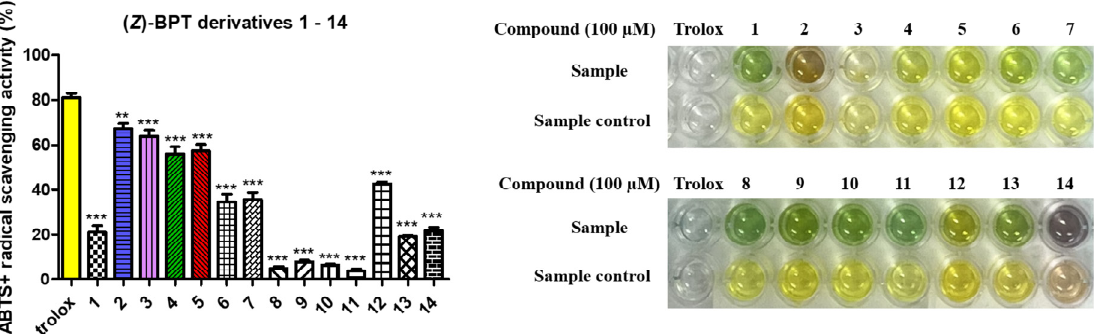
Figure 9. The ABTS cation radical scavenging effects of ( Z )-BPT derivatives 1 – 14 . Test samples 1 – 14 and Trolox, a positive control, were evaluated at a concentration of 100 µM. Asterisks (***) represent a significant difference between the ( Z )-BPT derivatives and Trolox, and results are expressed as the mean ± standard error of three different experiments. *** p < 0.001 and ** p < 0.01.